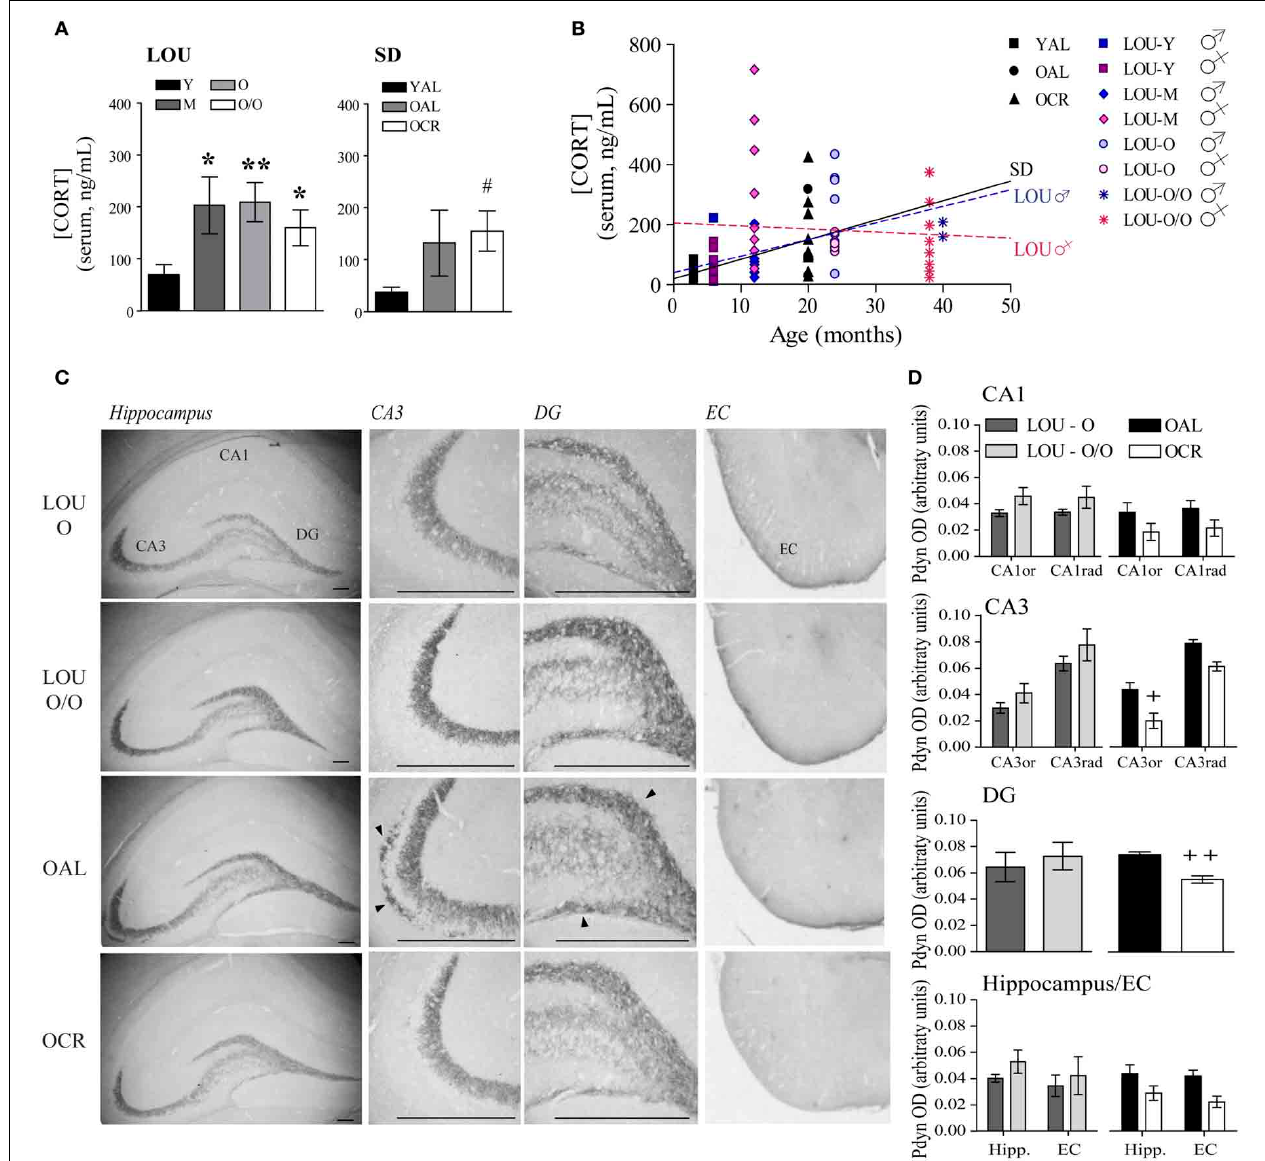
FIGURE 6 | The endogenous opioid prodynorphin is overexpressed in OAL SD rat hippocampus and entorhinal cortex. (A) Enhancement of circulating CORT was observed in 12-month-old LOU rats but remained stable thereafter. CORT levels increased in old SD rats and were significantly correlated with age in male SD and male LOU rats (B) . (C) Pdyn immunostaining is localized in the CA3 and DG hippocampal areas and entorhinal cortex. Scale bar at 500 μ m. Arrowheads indicate Pdyn-positive cells. (D) While Pdyn is highly expressed in the hippocampus CA3 and DG of